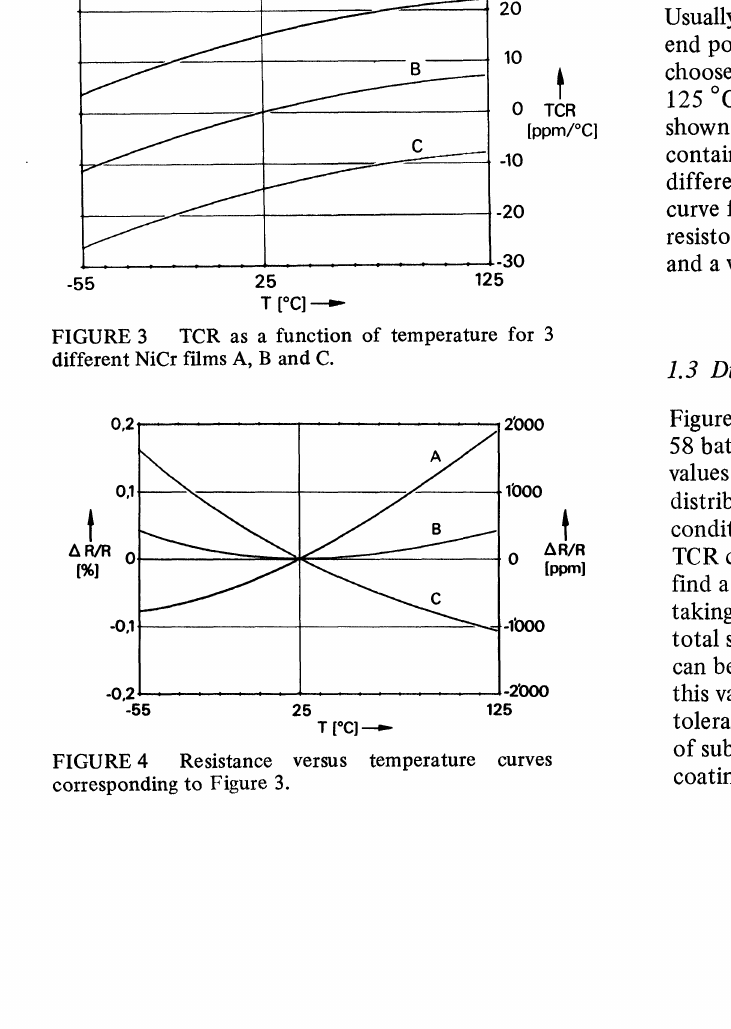
Possible resistance temperature specifications if only end values of a temperature interval are specified.